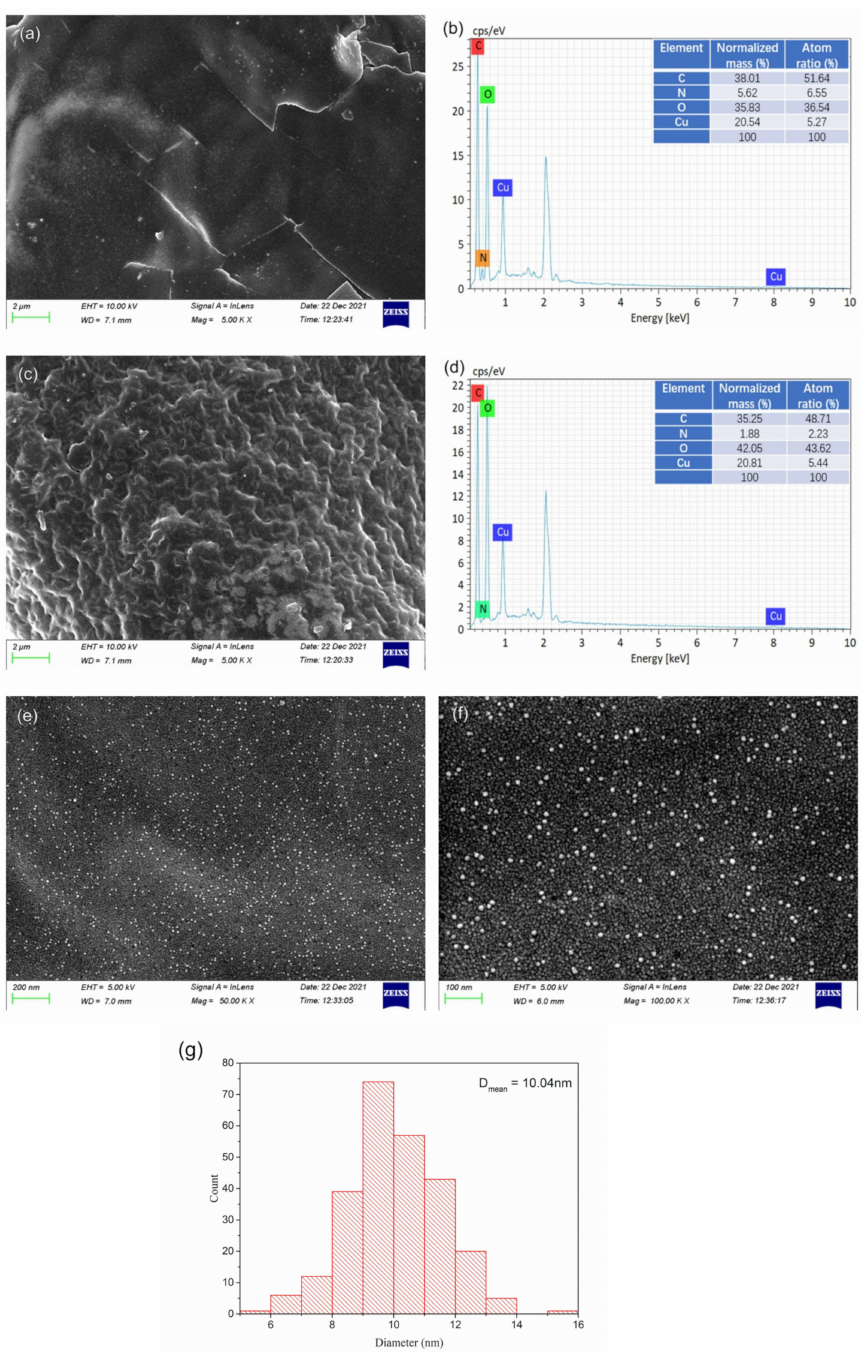
Figure 4. SEM images ( a , e , f ) and EDS data ( b ) of the obverse side of Cu II/I @CMC-PANI film; SEM images ( c ) and EDS data ( d ) of its back side; and histogram of particle size ( g